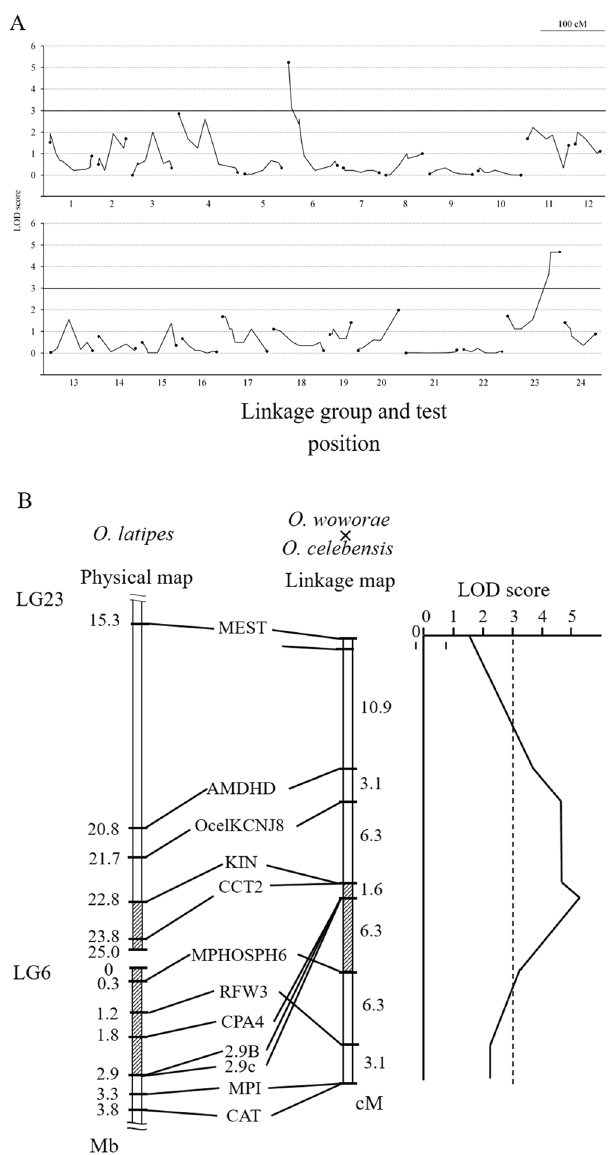
Figure 3. ( A ) Multipoint LOD scores for a genome-wide scan. Backcross (BC) progeny that survived or died within a 7-day exposure period (32 individuals each) in sea water were genotyped for 184 marker loci throughout the genome. Scores are plotted for marker loci spanning linkage groups (LG) 1–12 (upper tier) and 13–24 (lower tier). Relative lengths and marker distances along each LG will be reported elsewhere. Horizontal solid lines represent the threshold LOD score of 3. Closed circles at either end of a polyline indicate markers at the ends of each linkage map. ( B ) Linkage map of the hyperosmotic tolerance loci in F 1 adults of Oryzias woworae × O . celebensis and physical O . latipes LG 6 and LG 23 maps. The LOD score is indicated across the top and is plotted relative to the positions of the markers shown. The distance between flanking markers is shown as the physical length ( left ) or in cM ( right) . The shaded areas represent the region determining hyperosmotic tolerance on the genetic maps and the corresponding regions on the physical